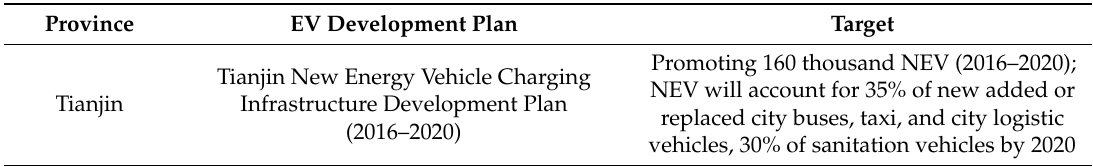
Table 1. EV promotion plans set by local